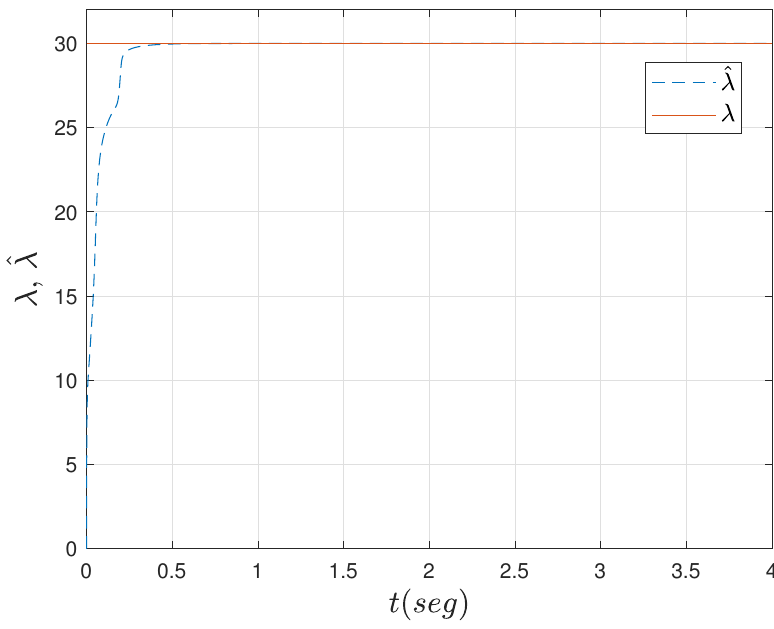
Figure 12. Progression of the convergence for ˆ λ .